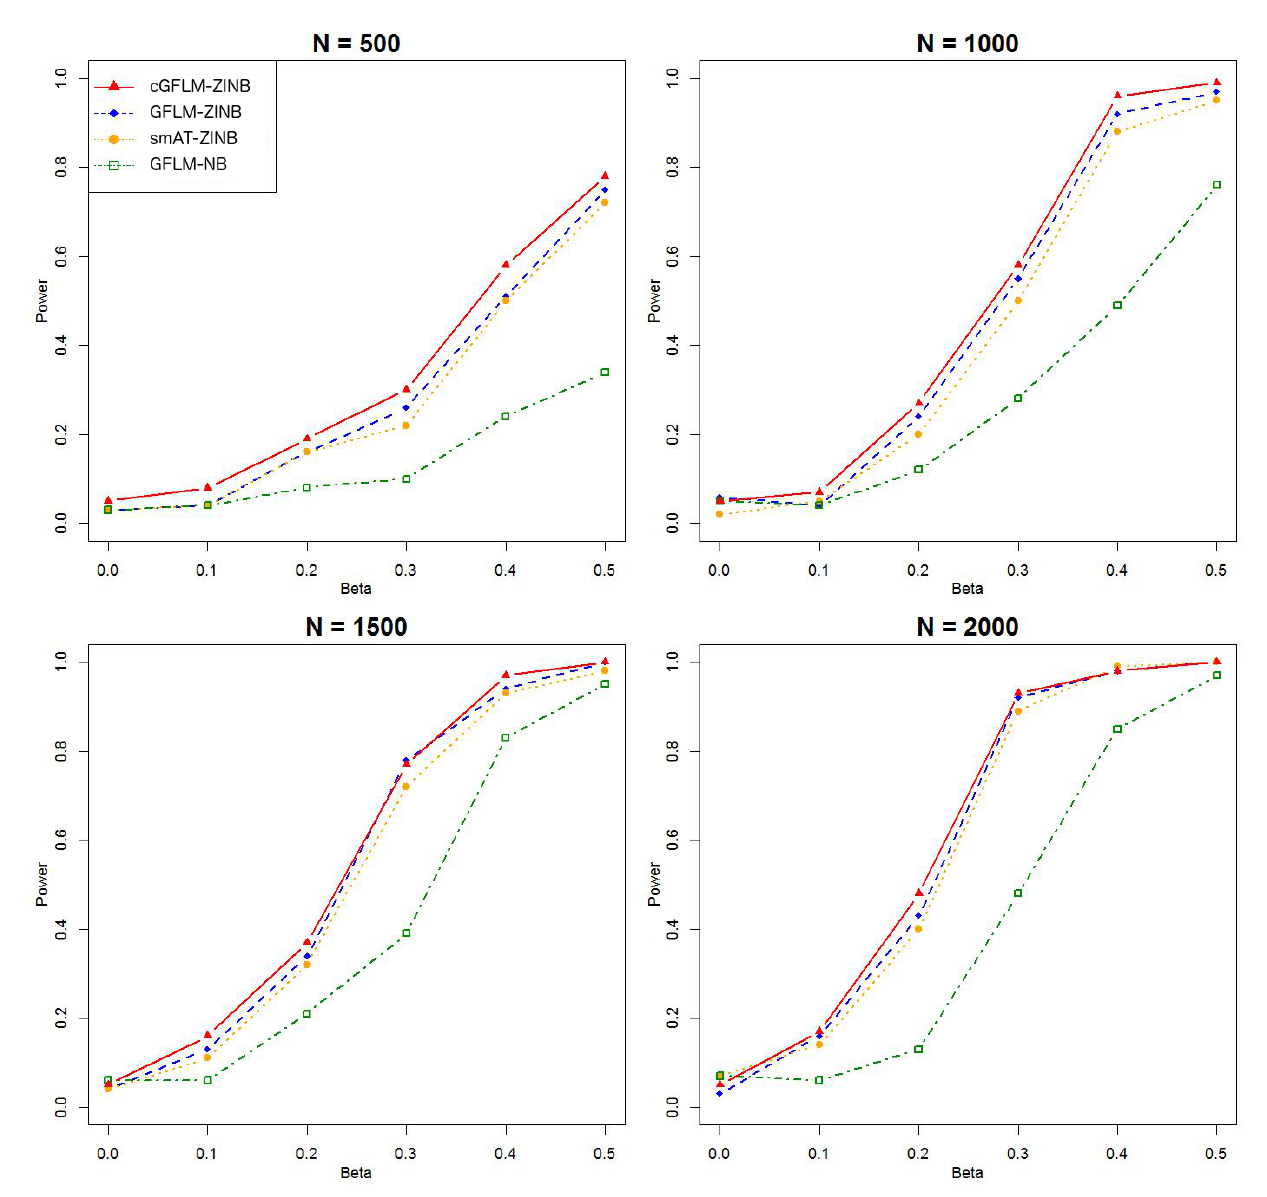
Figure A4. Power simulation for ZINB outcomes based on the CHRNA7 gene, two causal loci, effect in latent Bernoulli